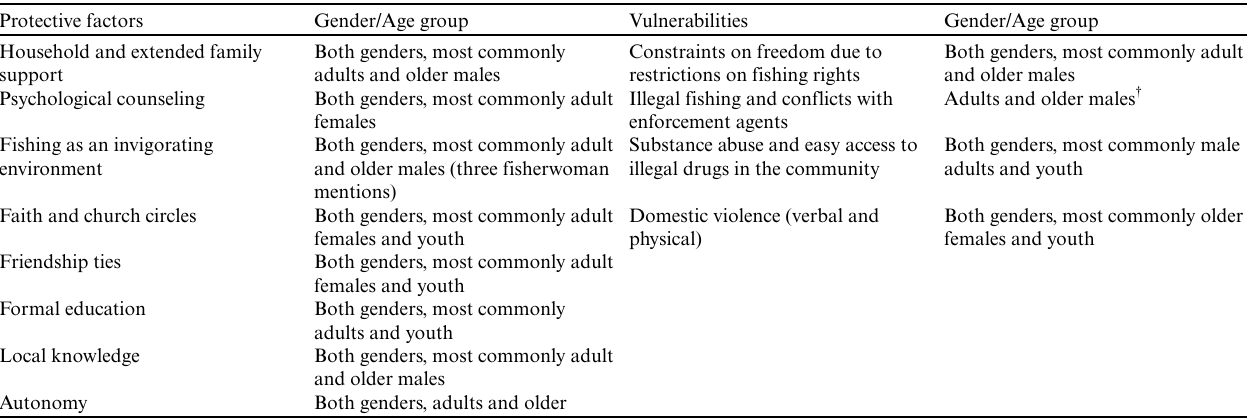
Table 4 . Protective factors and vulnerabilities identified as affecting individual